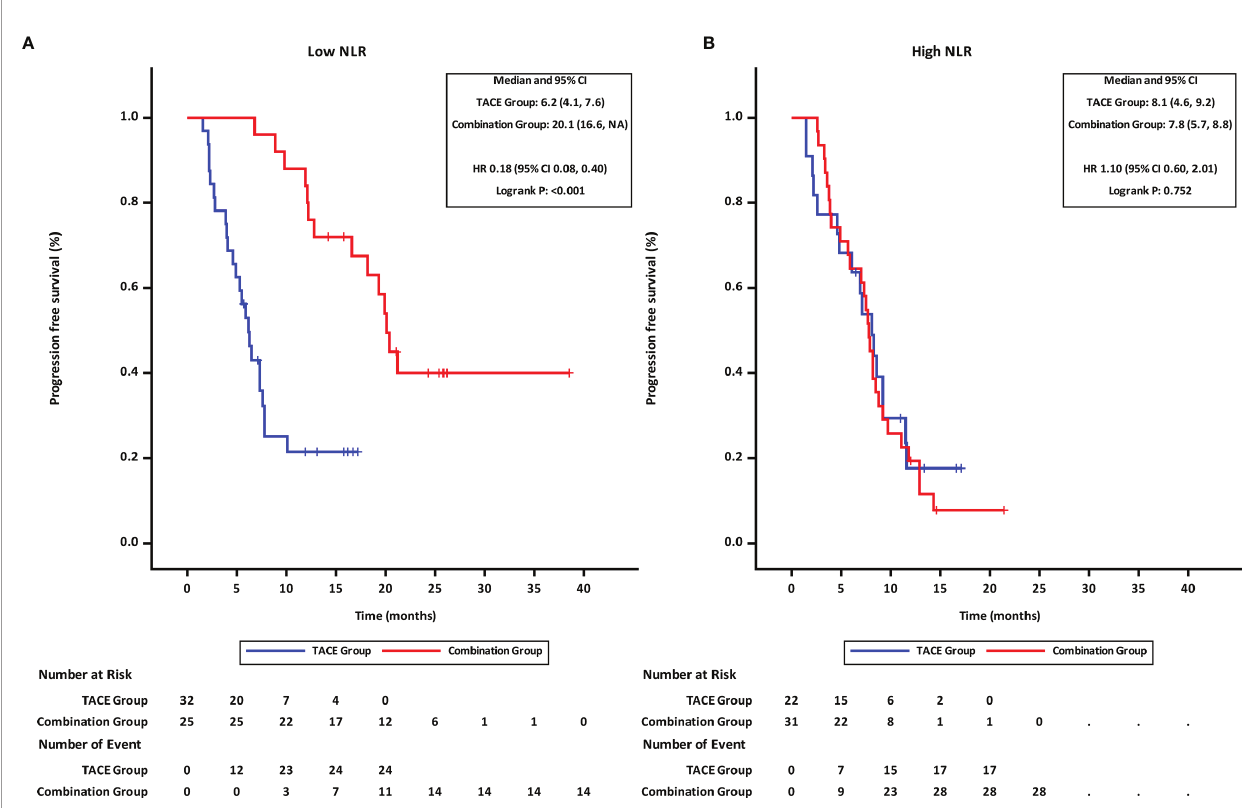
FIGURE 3 | Progression-free survival of groups of patients with different NLR statuses. (A) low NLR. (B) high NLR. TACE, transcatheter arterial chemoembolization; PD-1 programmed cell death-1; NLR, neutrophil-to-lymphocyte ratio; HR, hazard ratio; CI, con fi dence